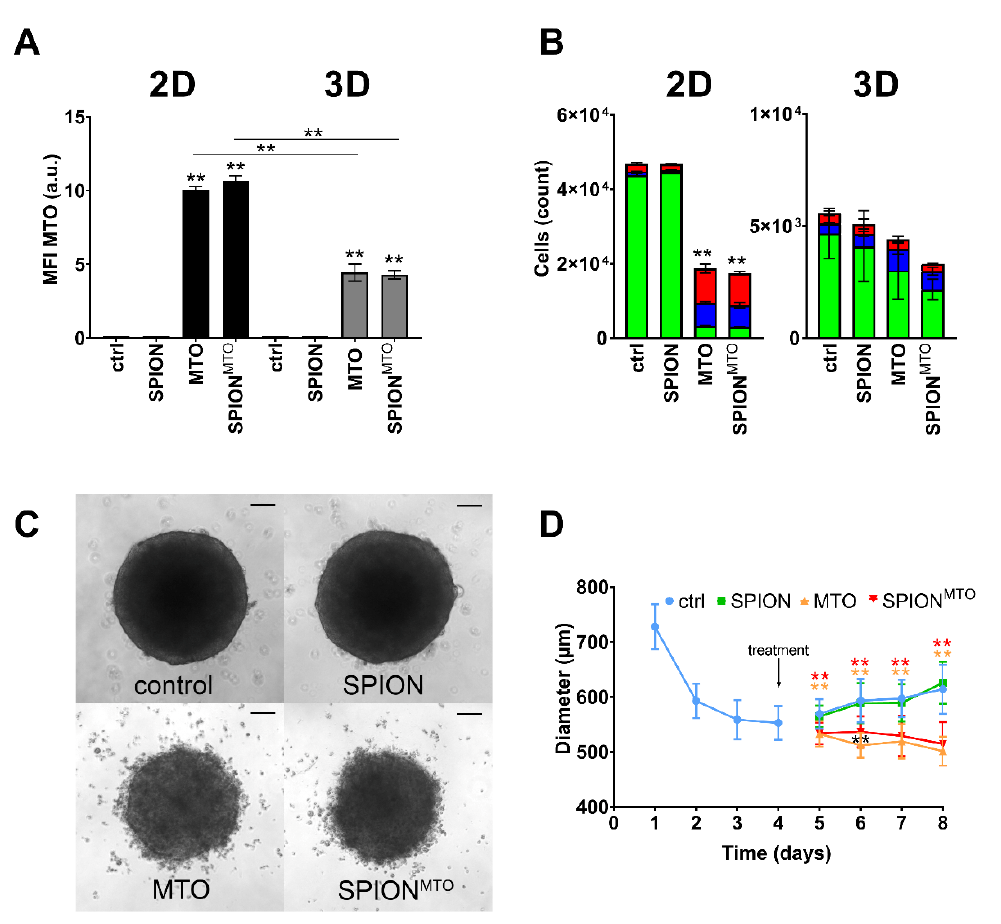
Figure 4. Comparison of e ffi cacy of MTO and SPION MTO in cells in monolayers or spheroids. HT-29 cells were cultivated in monolayers (2.5 · 10 4 cells in 12-well plates) or spheroids (10 4 cells in agarose-coated 96-well plates). After 24 h monolayer cells and after 96 h spheroids were treated with SPIONs, MTO or SPION MTO (MTO content 0.5 µ M each), H 2 O treated cells served as controls. For flow cytometry, single cell suspensions were prepared. Data were assessed after 96 h incubation with MTO. ( A ) Intracellular MTO accumulation in viable cells was analyzed by mean fluorescence index (arbitrary units, a.u.) of MTO in flow cytometry. ( B ) AnnexinA5-FITC / propidium iodide (Ax / PI) staining indicates viable (Ax − PI − , green), apoptotic (Ax + PI − , blue) and necrotic (PI + , red) cells. ( A , B ) Experiment was performed in two independent experiments in quadruplicates; shown are the mean values with standard deviations. ( C ) Brightfield microscopy of spheroids 4 days after treatment. Scale bars refer to 100 µ m. ( D ) Sizes of spheroids were determined by ImageJ software. ( C , D ) The experiment was performed in three independent experiments with six to nine single spheroids per condition each. Shown are the mean values with standard deviations. Significances were calculated using Student‘s t -test (* p ≤ 0.05, ** p ≤ 0.01; control versus treated samples, or monolayer versus spheroid; for 2B total cell counts were analysed). Abbreviations: Ax: Annexin A5; a.u. arbitrary units; FITC: